Question: Looking at the figure, what chart type is it?
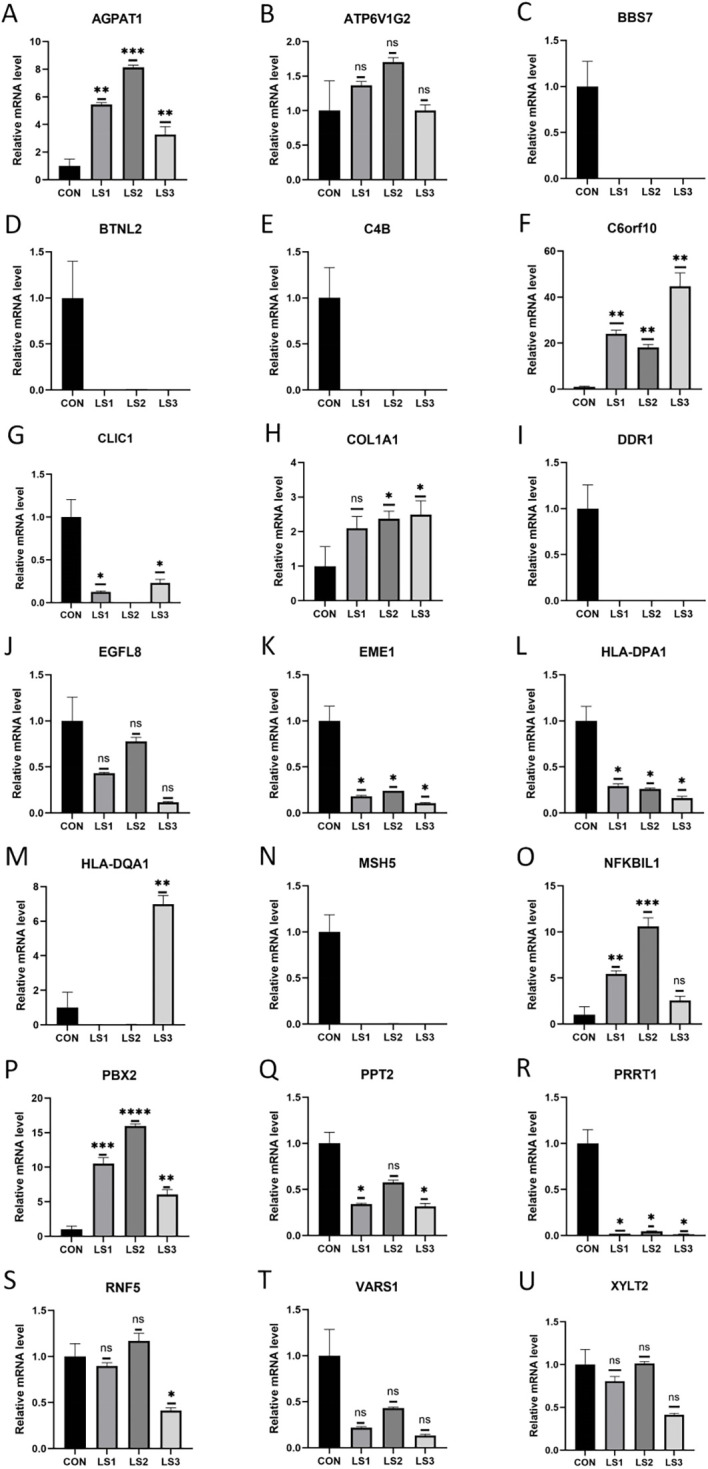
Answer: bar